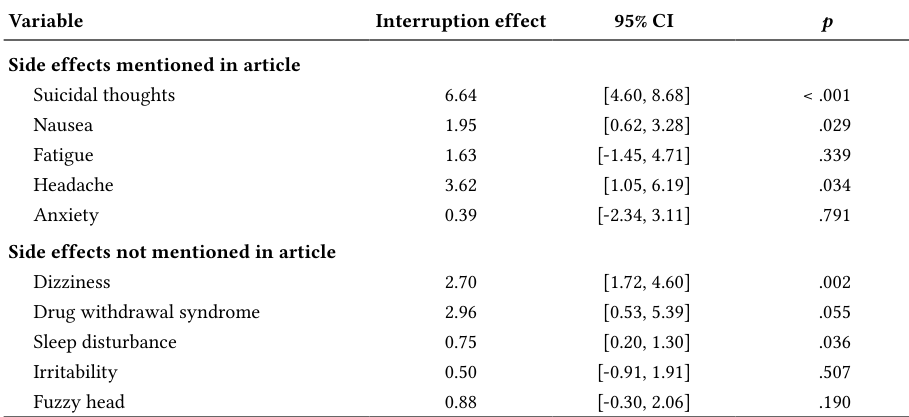
Estimated Interruption Effects of the Newspaper Articles on CARM Reports for Specifically Mentioned Side Effects and Control Side Effects Variable Interruption effect 95% CI